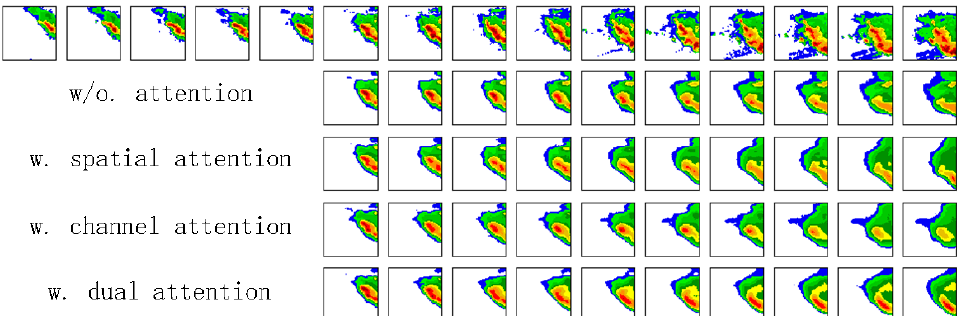
Figure 16. The attention mechanism ablation example from the CIKM AnalytiCup 2017 competition. The first five images in the first row are the input, and the remainders denote the ground-truth output. Other rows are the prediction of various models. (Best view in